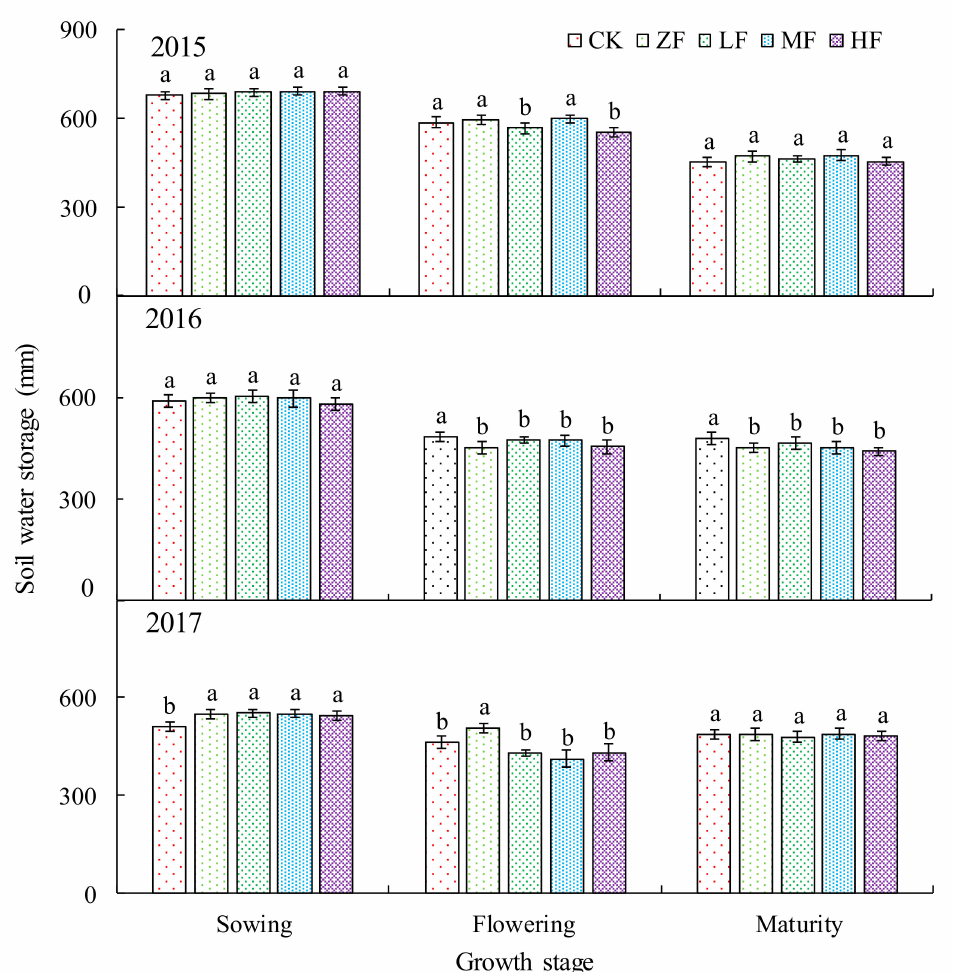
Figure 4. Soil water storage (SWS, mm) in the 0~300 cm soil depth at different growth stages of tartary buckwheat in 2015–2017. In each growing season, mean values (n = 3) followed by different letters within a column are significantly different among treatments at p < 0.05. Bars are error errors of the means (n =